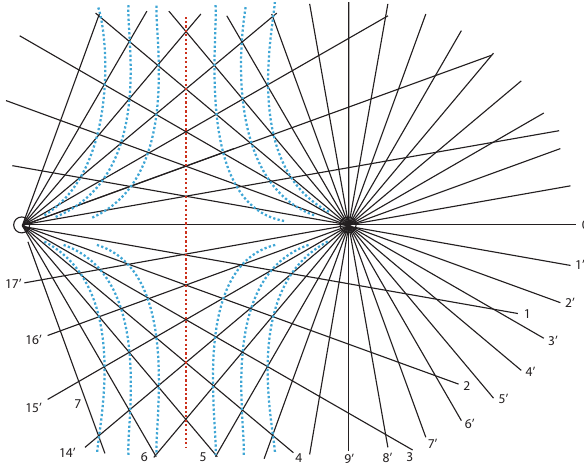
Fig. C1. Superposition of the equi-gauge potential lines 3 = const of two parallel magnetic field lines (elementary flux tubes carrying one flux quantum 8 o = 2 π ¯ h/e ). Equi-gauge potentials are exactly radial, emanating from their mother field line. The field lines are shown in their cross sections and point out of the plane. They are separated in space by some distance d . The equi-gauge potentials are clockwise numbered consecutively with the equi-gauge poten- tials of the right field line indicated by primes on the numbers. Since potentials add the superposition of the equi-potentials, generating the dashed repulsive potential pattern in the space between the field lines, this indicates that the interaction between a pair of parallel field lines is subject to